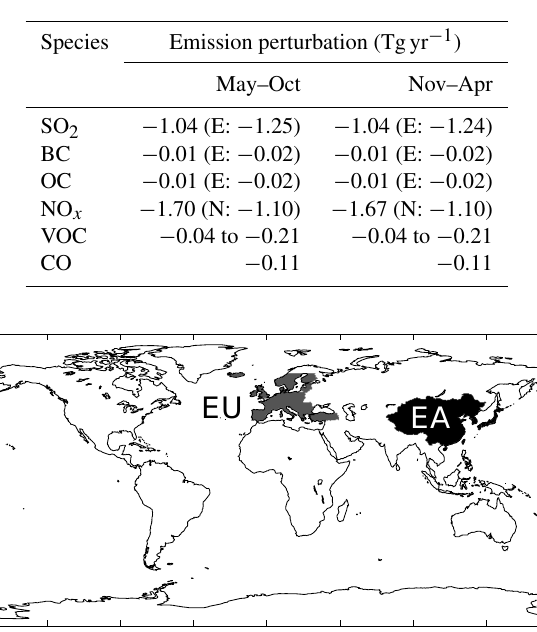
Table 4. Size of the emission perturbation applied to the shipping sector for the year 2008, in Tgyr − 1 . Emitted masses are in [C] for black and organic carbon, and volatile organic compounds. They are in [NO 2 ] for NO x . Emissions used in ECHAM6 and NorESM1 are denoted with E and N, where different.